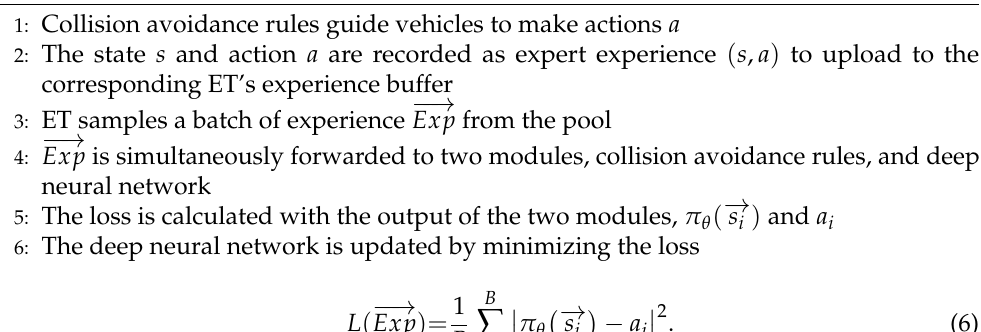
Algorithm 1: Imitation learning for motion